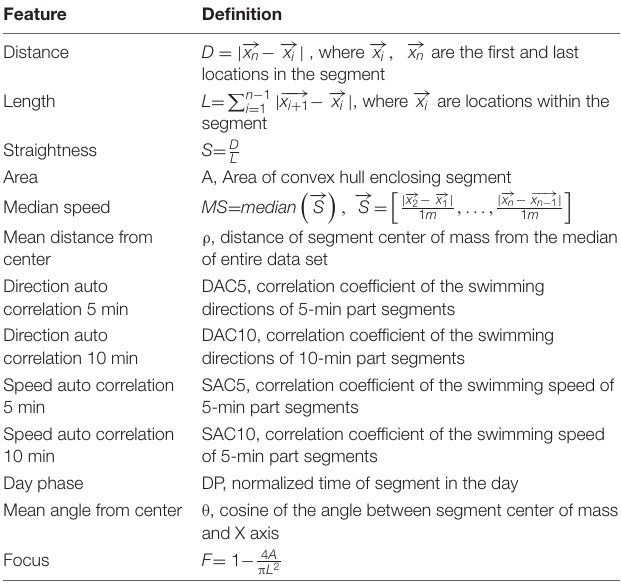
TABLE 1 | Features characterizing the geometric and temporal aspects of trajectory